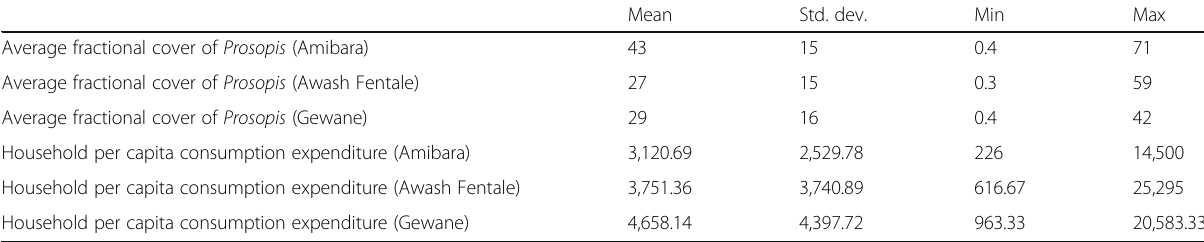
Mean Std. dev. Min Max